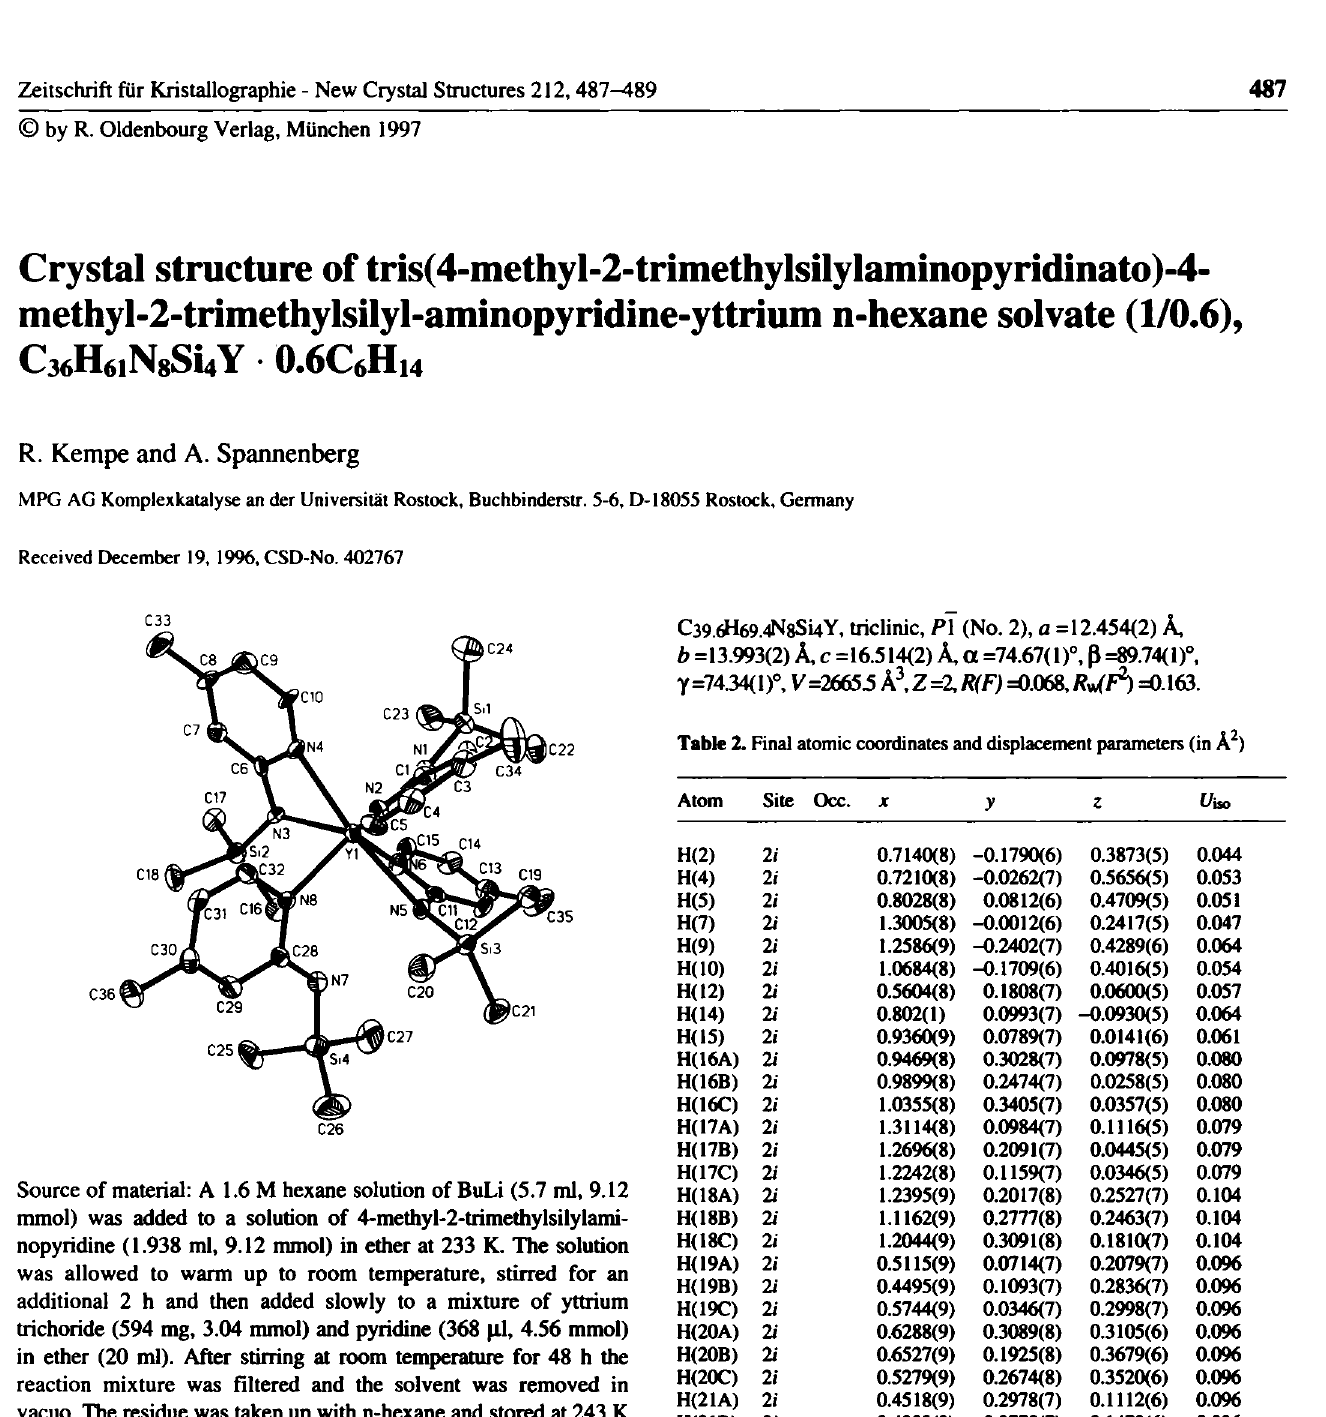
Table 1. Parameters used for the X-ray data collection Crystal: